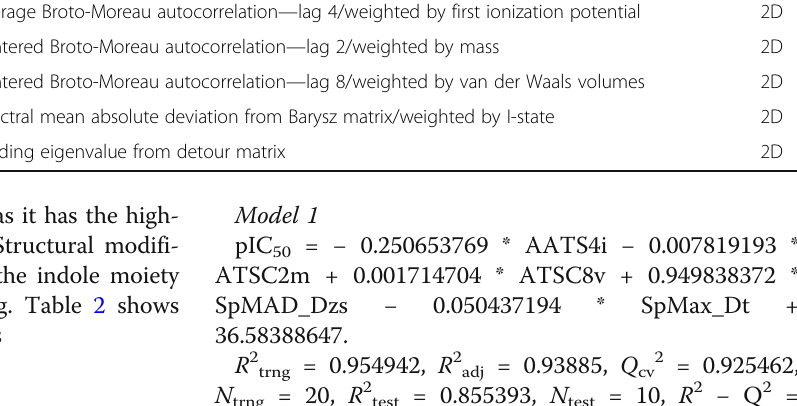
Table 3 The symbols, description, and classes of the descriptors of the selected model S/No Symbols